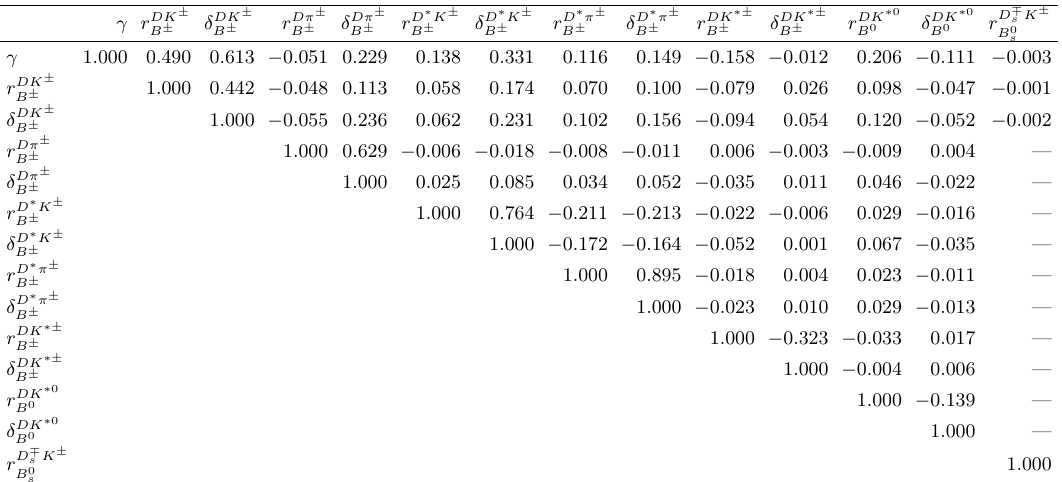
Table 7 . Correlation matrix of the fit result, part 1 of 3. Values smaller than 0 . 001 are replaced with a — symbol.